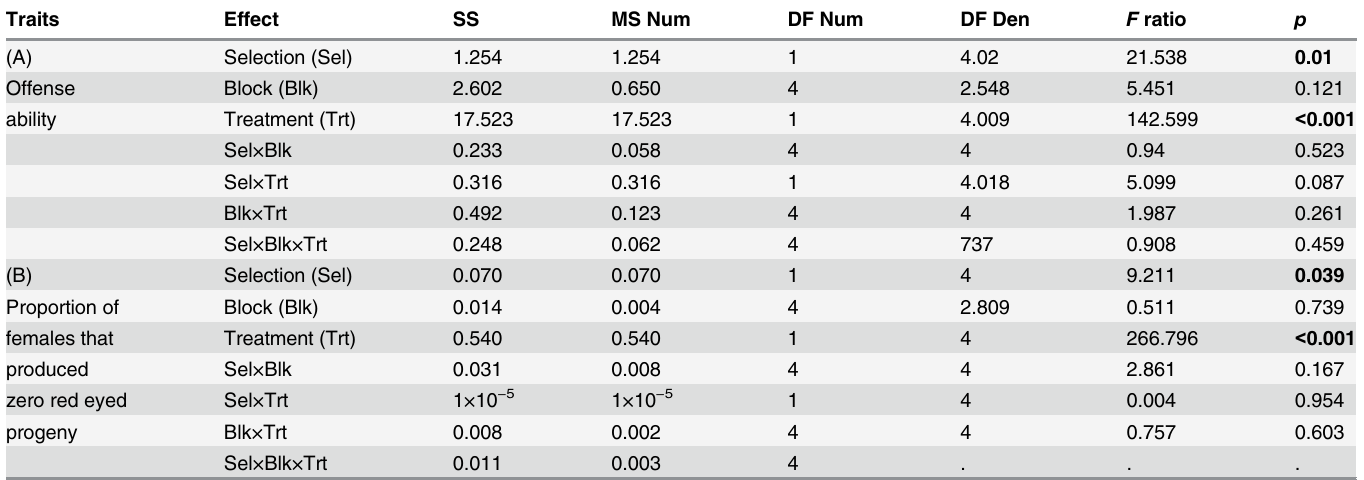
Table 6. Effect of cold shock on sperm offense ability. Summary of results from a three-factor mixed model ANOVA treating selection regime (FSB and FCB) and treatment (cold shock and no shock) as fixed factors crossed with block (1 – 5) as a random factor on (A) sperm offense ability and (B) proportion of females which produced zero red eyed progeny. p -values in bold are statistically